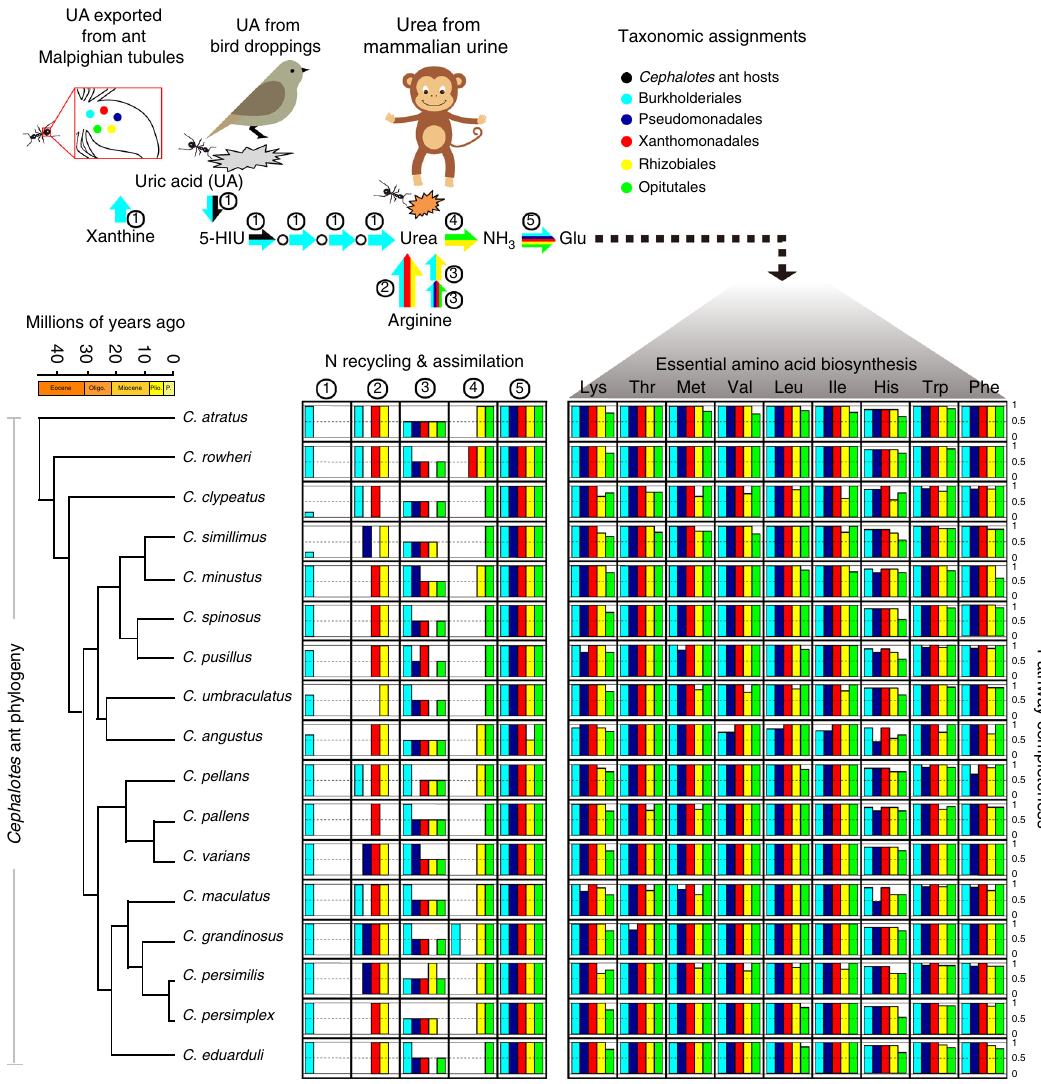
Fig. 4 Pathways for N-waste recycling and amino acid biosynthesis and their distributions across core gut symbionts from 17 Cephalotes species. Various symbiotic gut bacteria convert N wastes into ammonia, incorporate ammonia into glutamate, and synthesize essential amino acids. The proposed model in the upper panel shows sources of the N-waste uric acid (bacterial metabolism via xanthine degradation, bird droppings, host ant waste metabolism via Malpighian tubule delivery) and urea (mammalian urine, uric acid metabolism, and arginine metabolism). Arrows in this panel are colored to re fl ect taxonomy of the core Cephalotes -speci fi c microbes participating in these steps in multiple metagenomes. Numbers near arrows link particular pathways to bar graphs (below), which in turn plot pathway completeness (i.e., proportion of all genes present) for the dominant core taxa in each metagenome. At left on the lower panel is the phylogeny of Cephalotes species used for metagenomics including a chronogram dating divergence events in these species ’ history 27 . The bird and monkey images used in the upper panel were created using Adobe Illustrator CS6 (v. 16.0.0) and the ant image is an Adobe Illustrator clipart N fi xation genes appear absent in metagenomes . Consistent